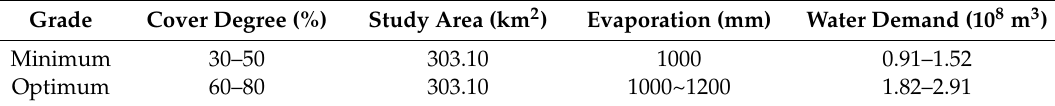
Table 1. Water demand for wetland plants.